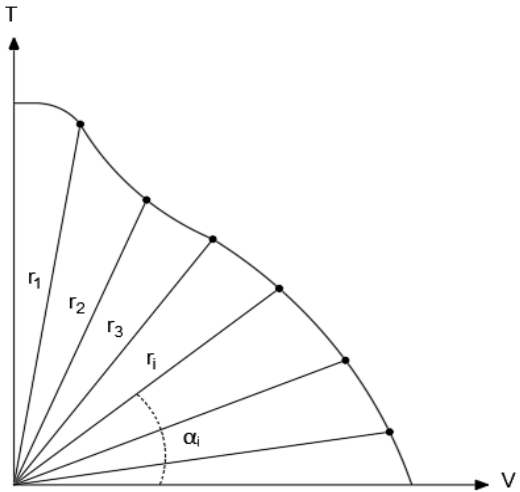
Figure 2. Modeling the optimized torque–shear curve.